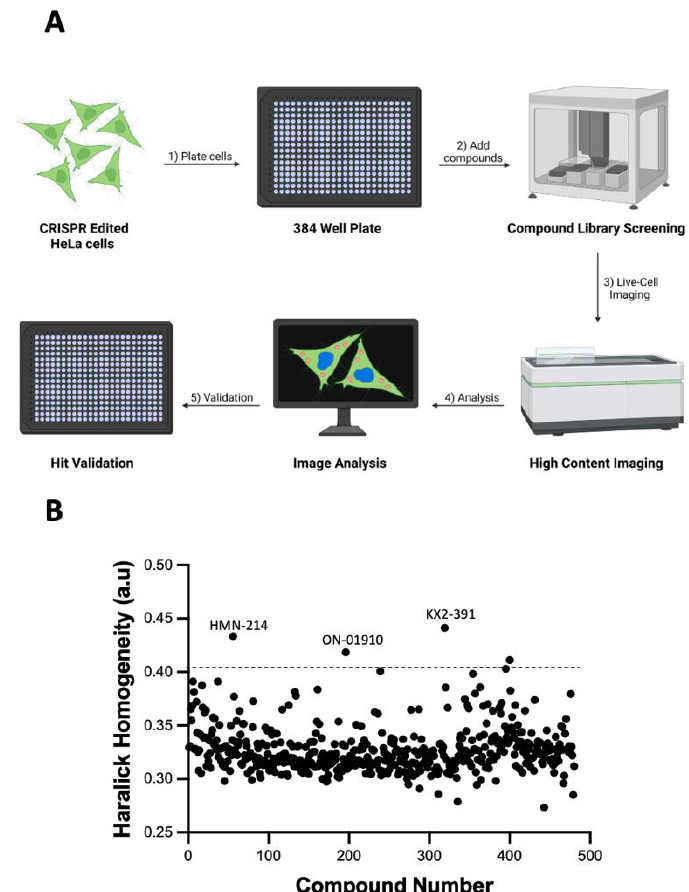
Figure 2. Kinase inhibitor library screening with HCI analysis of live cells. ( A ) Diagram of the steps required to detect phenotypic changes of CRISPR-edited HeLa cells after treatment with a library of kinase inhibitors. The cells are plated into 384 glass-bottom plates and treated with the compounds 16 h later. Following a 24 h incubation period, the cells are imaged directly without cell fixing or immunostaining. The images are analyzed to detect changes in the Haralick homogeneity values as described in Figure 1A. Lastly, the positive hits are further validated. ( B ) Changes in the Haralick texture homogeneity values of cells treated with a library of 429 kinase inhibitors. Compounds that change the Haralick texture homogeneity higher than the mean of all the compounds plus three standard deviations (dashed line) were considered positive hits for further evaluation. Three compounds (ON-01910, KX2-391, and HMN-214) were manually checked and selected for validation. These data are representative of three independent